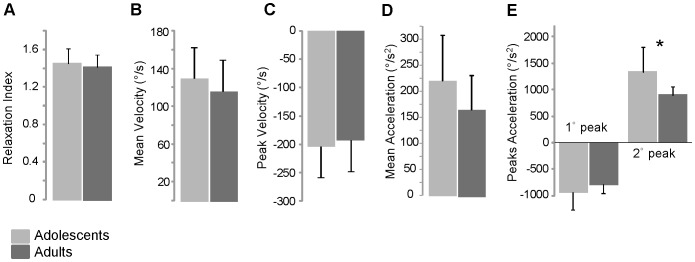
Summary of statistic of kinematic parameters.Means and standard deviations of kinematic parameters measured in adolescents and adults with Down syndrome (A–E). * P<0.05.